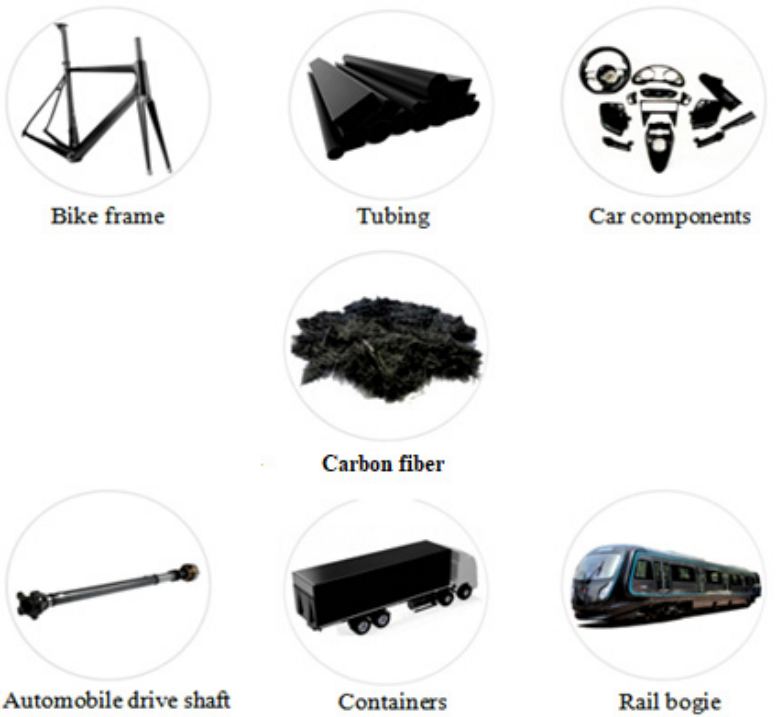
Figure 12. Application of carbon fiber in various sectors [106].